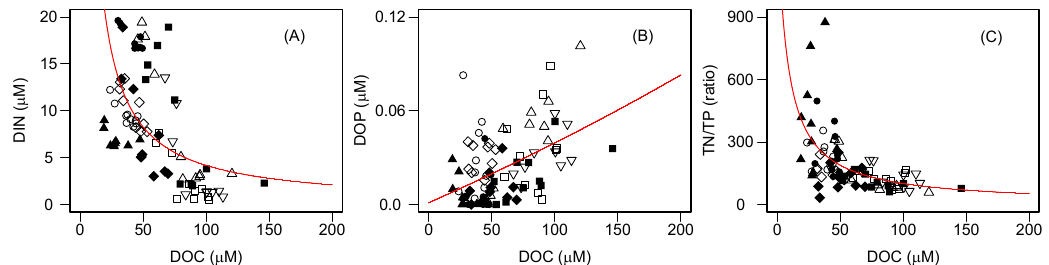
Figure 3. Relationships between dissolved organic carbon (DOC) and chemical variables in the study lakes. Univariate regression lines estimated by the best GLMs with a gamma distribution of the response variable ( y ) are shown. See the legend for Figure 2 for a description of the symbols.